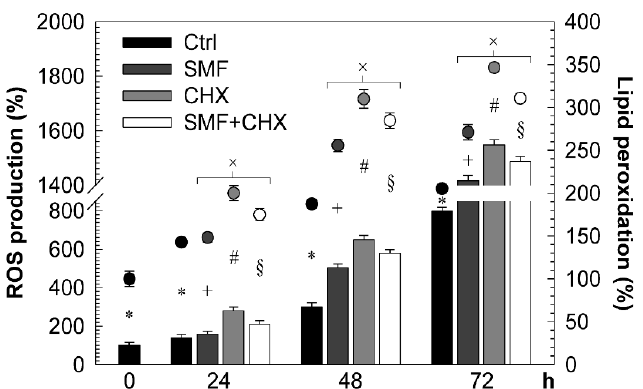
Figure 4. ROS production and lipid peroxidation. ROS production and lipid peroxidation of PBLs following different treatments, quantified by performing the nitro blue tetrazolium (NBT) assay (histograms) and ThioBarbituric Acid (TBA) assay (dots). All values plotted relate to the value of control PBLs at the time-point 0 h, taken as 100%. The error bar represents the SE of five independent experiments, each performed in duplicate. × indicates a significant value than control ( p < 0.05), whereas * ( p < 0.0083) and + , # and § ( p < 0.0167) indicate significant values compared to those indicated with the same symbol. Abbreviations: Ctrl = control PBLs, SMF = PBLs exposed to 6-mT SMF, CHX = PBLs treated with 10-mM CHX, SMF + CHX = PBLs exposed to SMF and treated simultaneously with CHX and h =